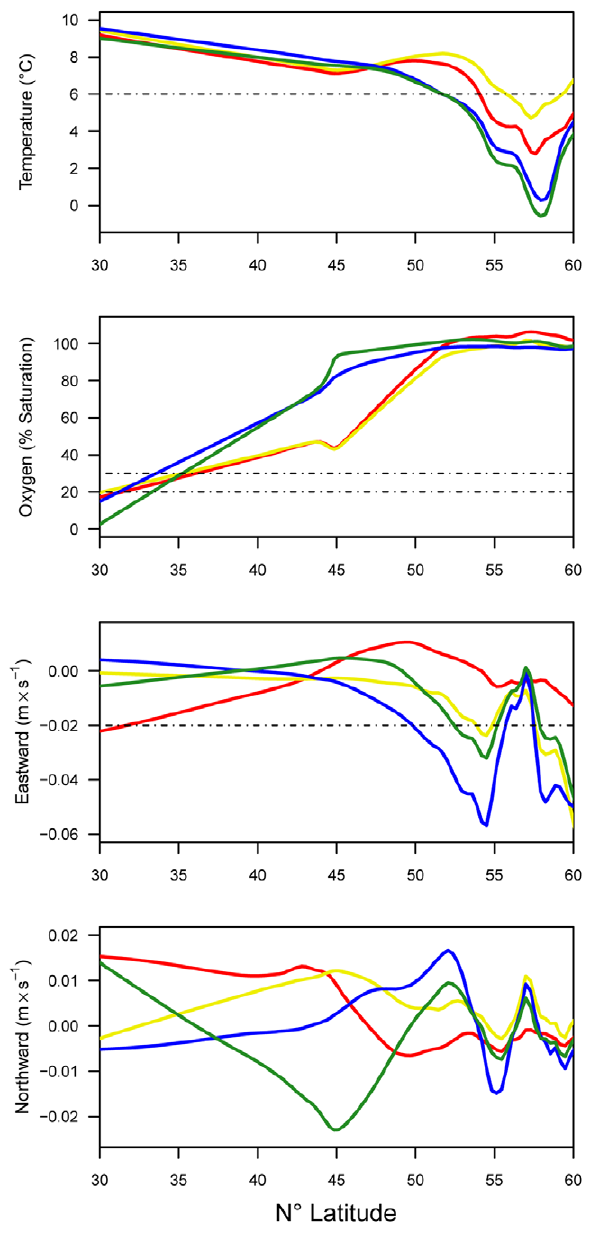
Figure 4. Predicted green sturgeon distribution. Probability of presence interpolated from MaxEnt background predictions averaged across all seasons (maximum probability=0.7, minimum probability=0). Individual season interpolations are displayed in Figure S4. Black dots indicate green sturgeon presence aggregated per 10 km 2 from the West Coast Groundfish Observer Program (see Figure S3). The background layer is from the ESRI Ocean Basemap (2012). The map is displayed in the Albers Equal Area projection.